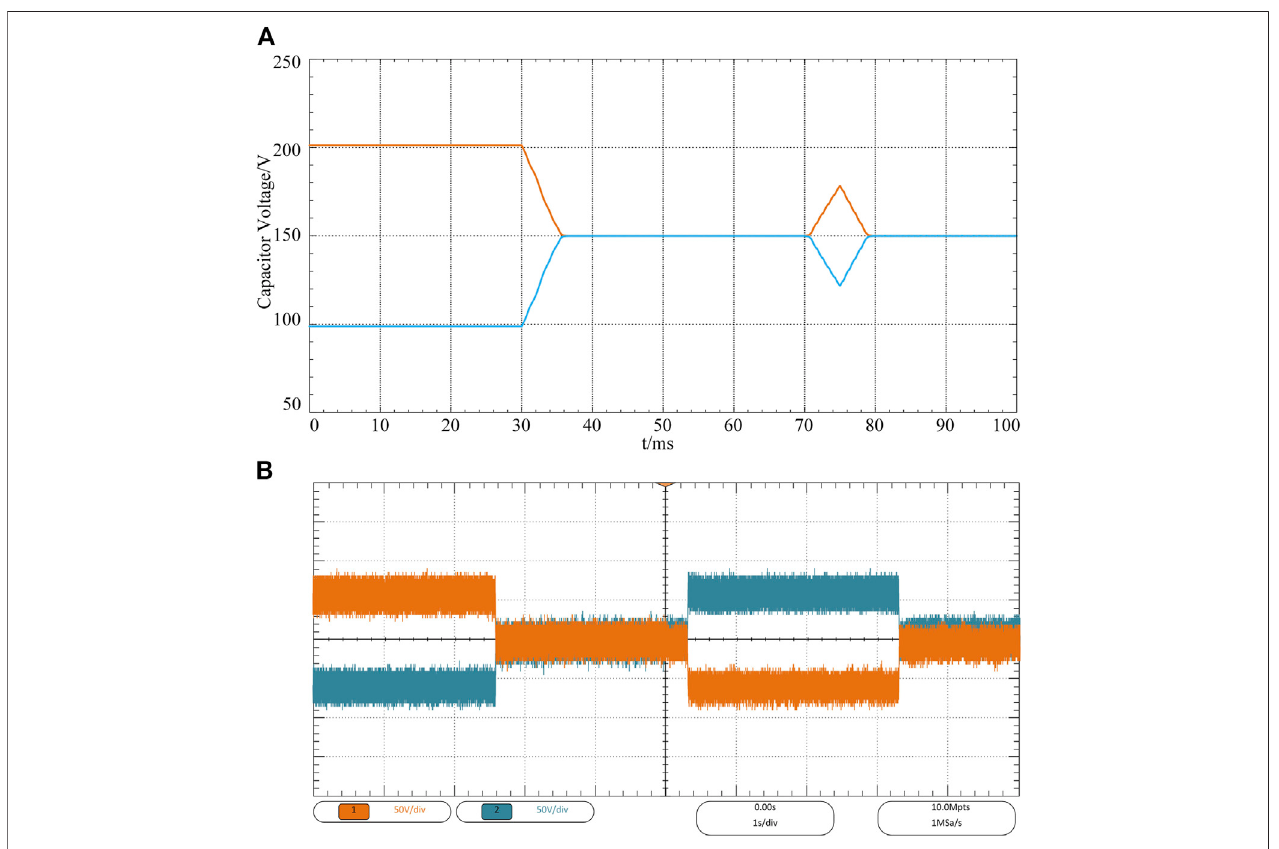
FIGURE 13 | Waveforms of capacitor voltages: (A) simulation, (B)